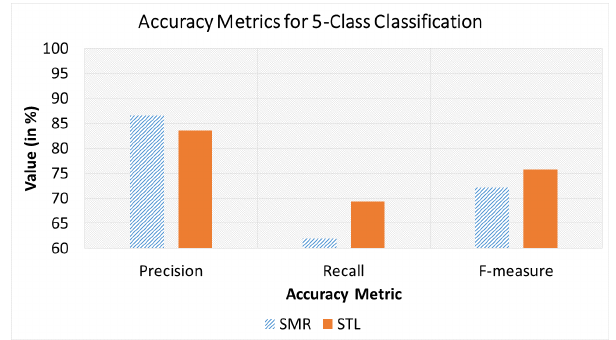
Figure 7: Precision, Recall, and F-Measure values using self-taught learning (STL) and soft-max re- gression (SMR) for 5-class when applied to test